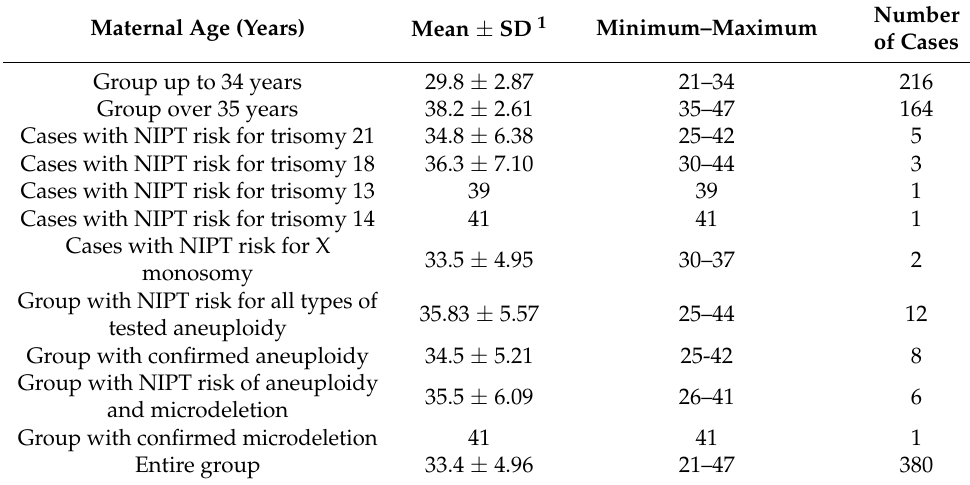
Table 3. Mean maternal age in different